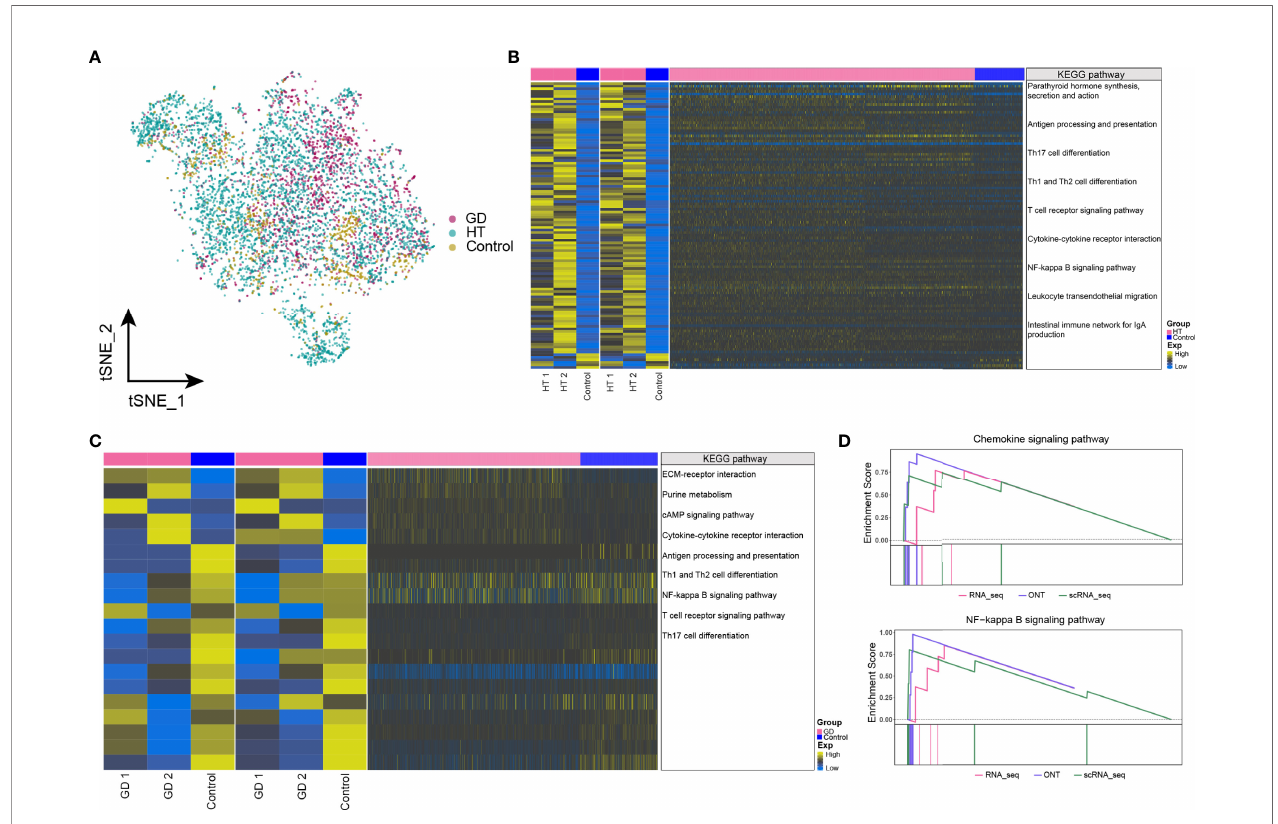
FIGURE 5 | Dysregulated gene expression and abnormal metabolic signaling in microenvironmental CD8 + T cells in HT and GD. (A) Single-cell tSNE plots demonstrating HT, GD, and control microenvironment CD8 + T-cell pro fi les. (B, C) KEGG pathway involved in genes with high con fi dence of dysregulated expression at the bulk level and in CD8 + T cells in HT (B) and GD (C) patients. Heatmap of DEGs from ONT sequencing on the left, heatmap of DEGs from RNA sequencing in the middle, and heatmap of DEGs from CD8 + T cells on the right. (D) Composite GSEA plot demonstrating the signi fi cantly dysregulated KEGG pathway of microenvironmental CD8 + T cells in HT. EXP, expression; GD, Graves ’ disease; HT, Hashimoto ’ s thyroiditis; KEGG, Kyoto Encyclopedia of Genes and Genomes; ONT, Oxford Nanopore